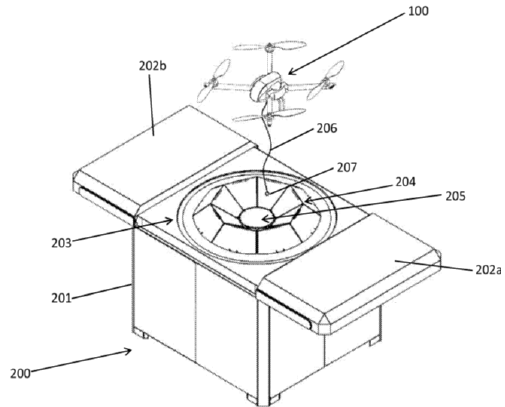
Figure 25. Landing platform for a vertical take-off and landing UAV with a trapezoidal segment cone for positioning [72] by Airobotics Ltd. (Petah Tikva, Israel). 100, the UAV; 203, a landing site; 204, the centering device consisting of trapezoidal segments 203; 205, centering magnetic assembly; 206, a cable; 207, a